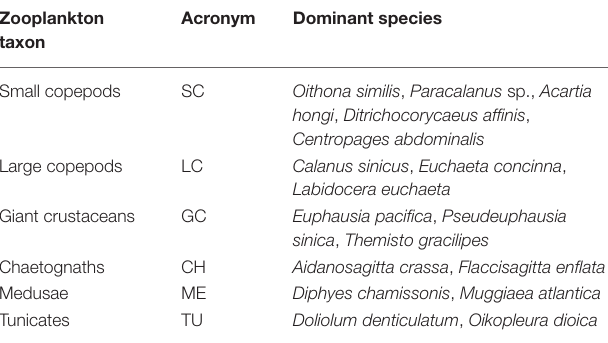
TABLE 4 | Dominant species of six zooplankton taxa in the Yellow